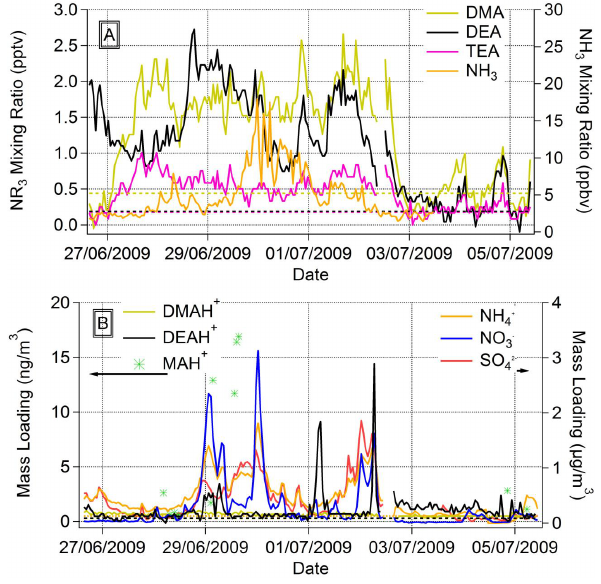
Figure 6. Online AIM-IC observations of amines and dominant inorganic constituents in (A) the 3 Fig. 6. Online AIM-IC observations of amines and dominant in- gas phase and (B) PM 2.5 . In each panel, the left axis applies to amines, and the right axis to 4 organic constituents in (A) the gas phase and (B) PM 2 . 5 . In each inorganic consituents. Detection limits for amines are depicted using dashed lines. 5 panel, the left axis applies to amines, and the right axis to inorganic consituents. Detection limits for amines are depicted using dashed